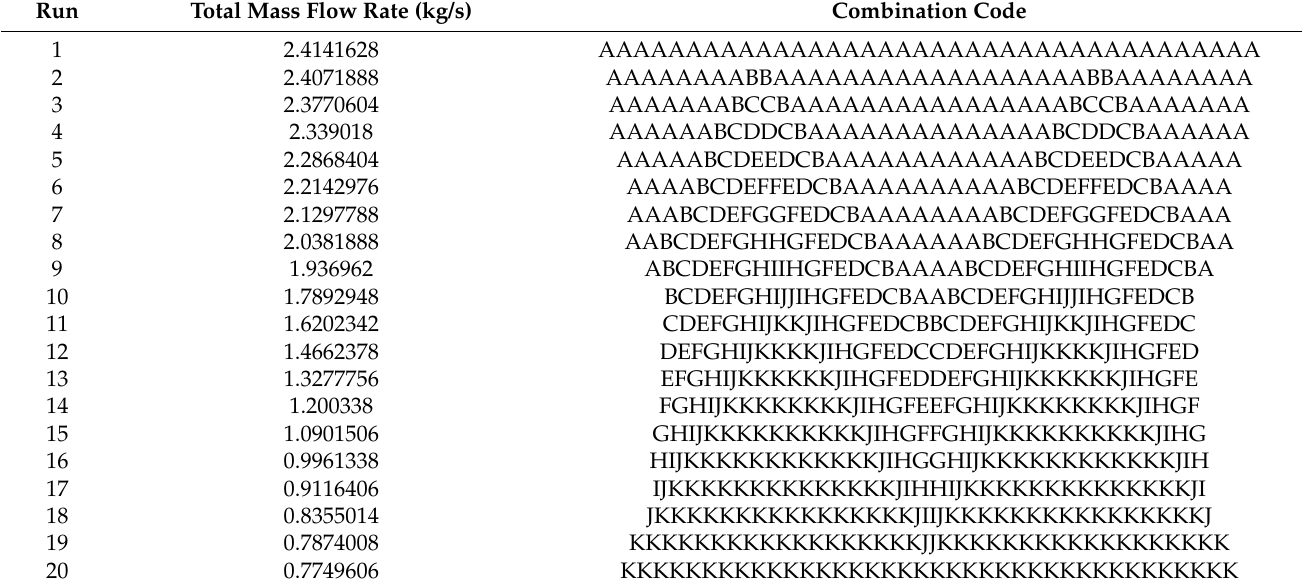
Table 3. Combinations of mass flow rates for two stall cells.